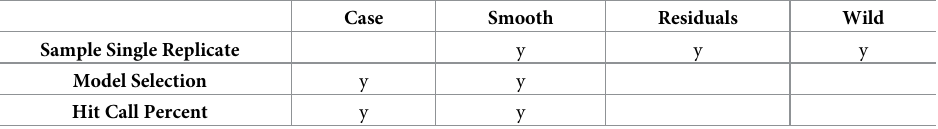
Table 1. Applicability of bootstrap methods to assays with only one measurement per concentration, determina- tion of a winning model, and calculating a hit call probability. Case Smooth Residuals